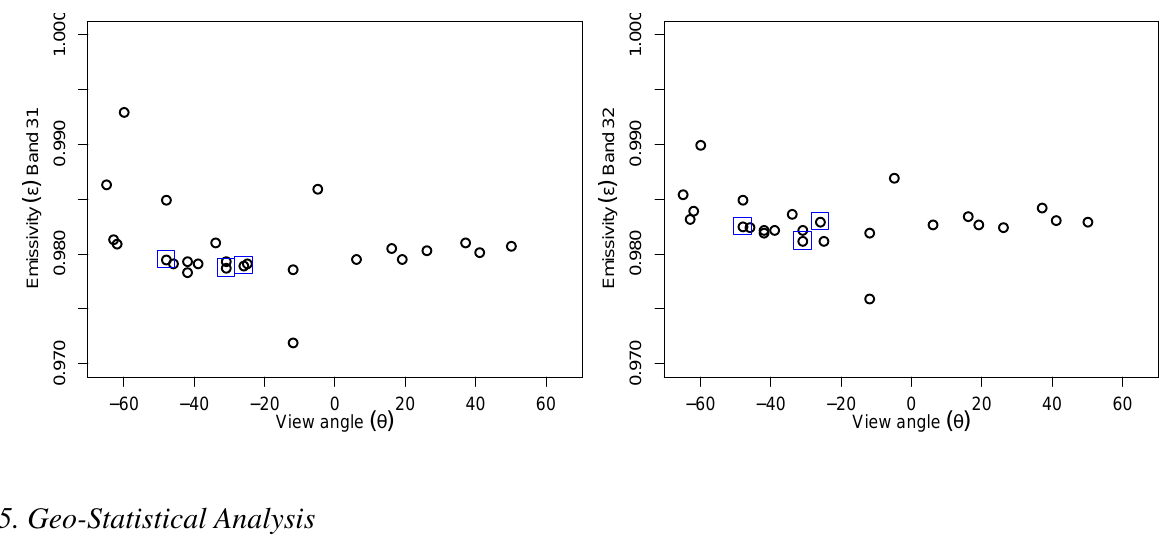
Figure 6. View zenith angles ( θ ) versus emissivities ( (cid:15) ) in bands 31 & 32 (outliers are marked by a